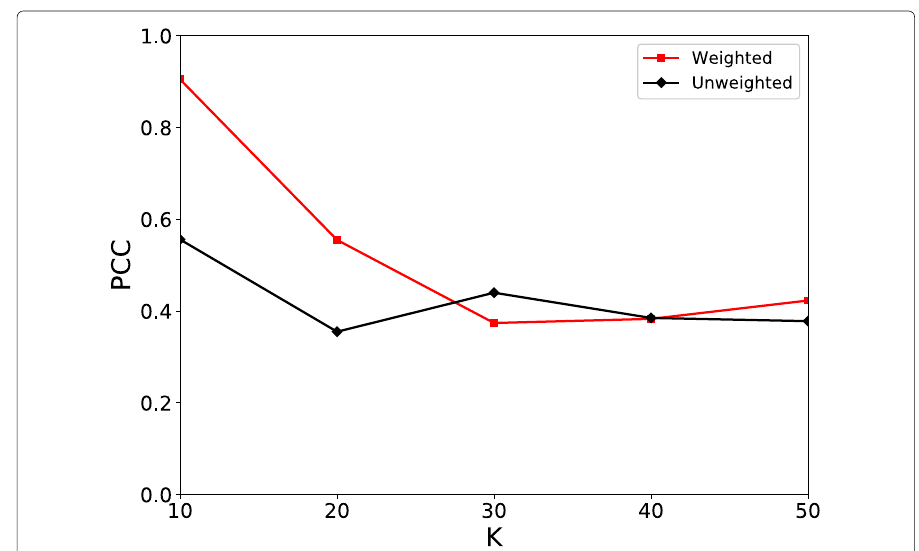
Fig. 8 Impact of edge weight. The horizontal axis K indicates the number of initial infected nodes in SIR modeling. The vertical axis N I indicates the number of final infected nodes (including infected and removed nodes)